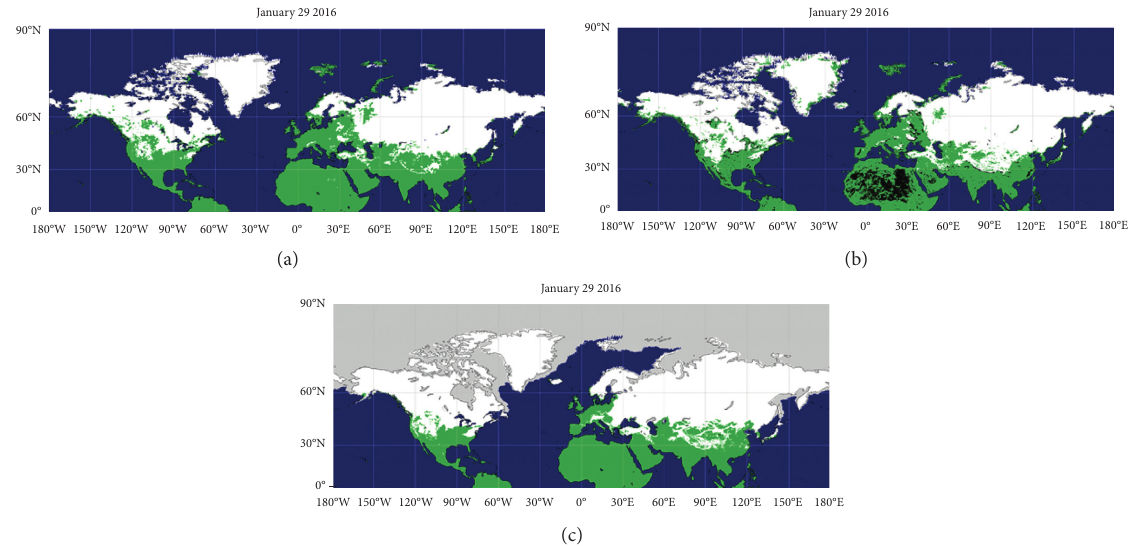
Figure 1: Example (a) MIRS, (b) MSPPS, and (c) IMS maps for January 29, 2016. MIRS shows sea, land, and snow classes. MSPPS shows other (black), sea, land, and snow classes. IMS shows sea, land, sea ice (grey color), and snow cover